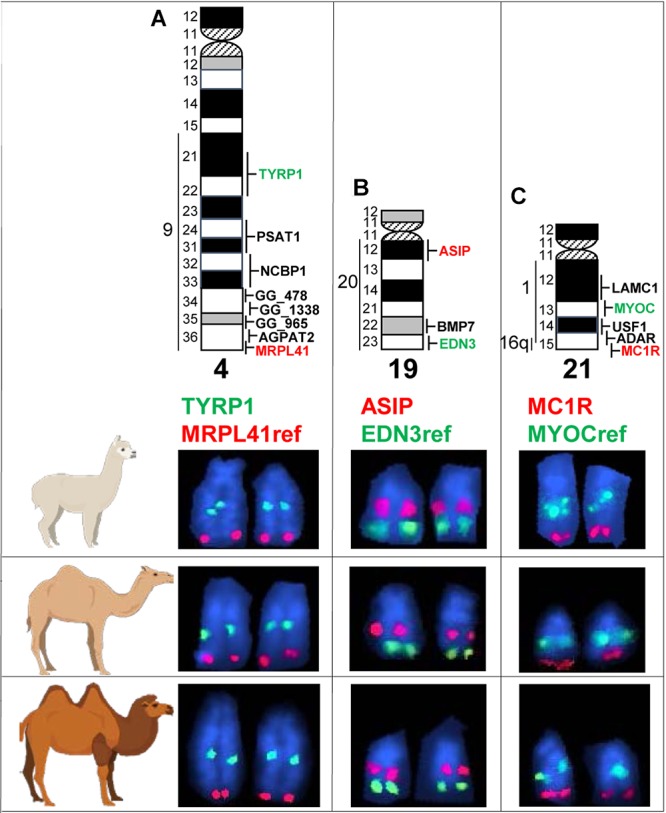
Comparative FISH mapping. Comparative mapping of TYRP1
(A), ASIP
(B), and MC1R
(C) in alpaca, dromedary, and Bactrian camel chr4, chr19, and chr21, respectively. Chromosome ideograms with all mapped markers (Avila et al., 2014a) are shown at the top. Vertical lines with numbers to the left of chromosome ideograms indicate homology segments to human chromosomes. Ref, reference gene for chromosome identification. Green and red font colors for coat color genes and reference genes correspond to the green and red FISH signals in partial microscope images below ideograms.